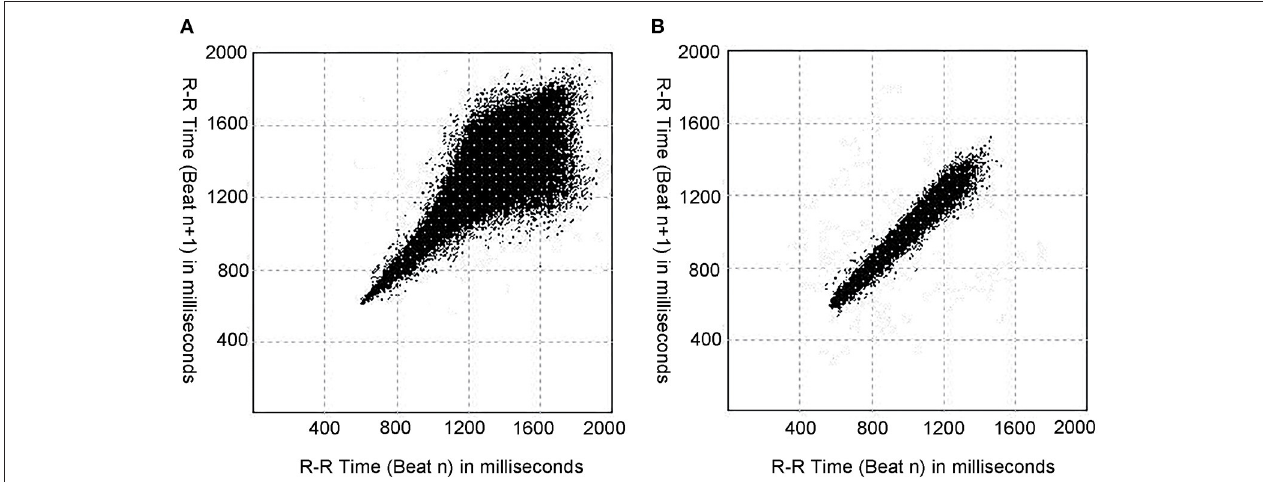
FIGURE 2 | Typical Poincaré plots in a patient with VVS and a patient with POTS. (A) The Poincaré plot of a patient with VVS (male, 11 years old). (B) The Poincaré plot of a patient with POTS (male, 11 years old). As shown, the patient with VVS and the patient with POTS have different typical graphics of Poincaré plot, and the Poincaré plot of the patient with VVS tend to be tennis racket-shaped, while that of the patient with POTS tend to be baseball bat-shaped. VVS, vasovagal syncope; POTS, postural tachycardia syndrome.